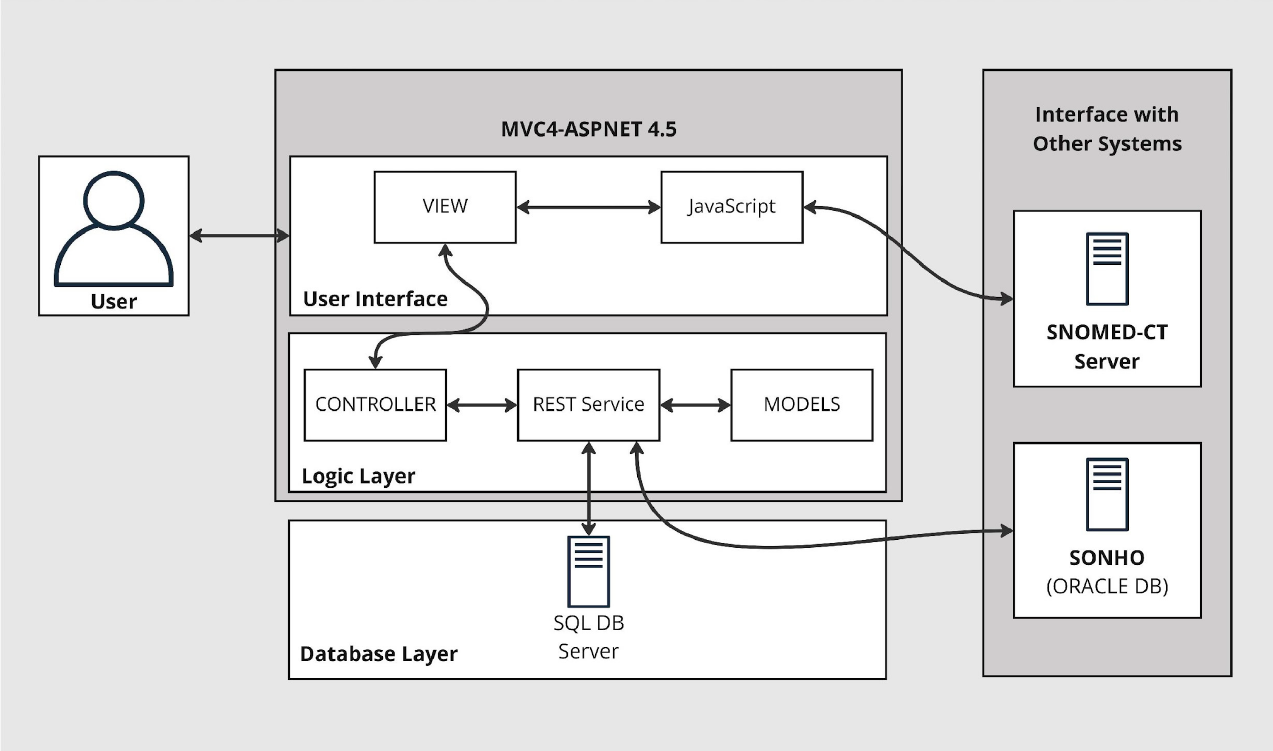
Figure 1. The architecture of the proposed solution. A three-layered system to extend the SClínico EHR and interfacing with a SNOMED-CT server and SONHO database.